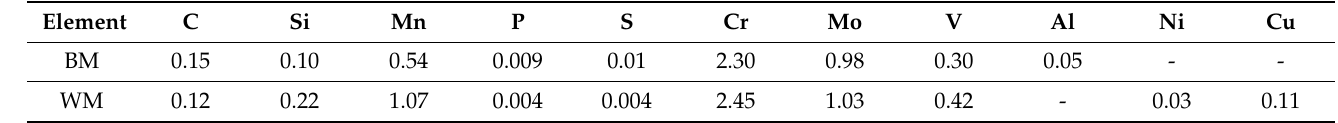
Table 1. Chemical composition of 2.25Cr1Mo0.25V steel base metal (BM) and weld metal (WM) (all elements are in